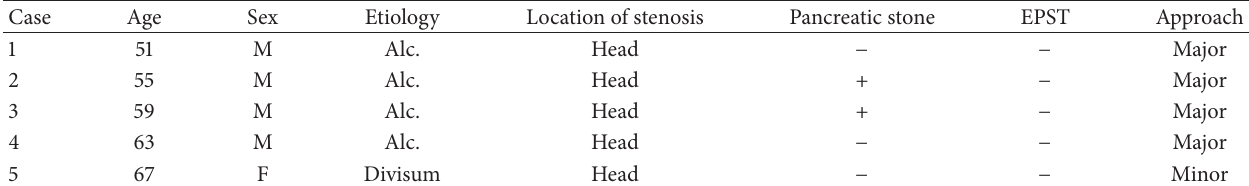
Table 3: Patients characteristics of migrated cases.